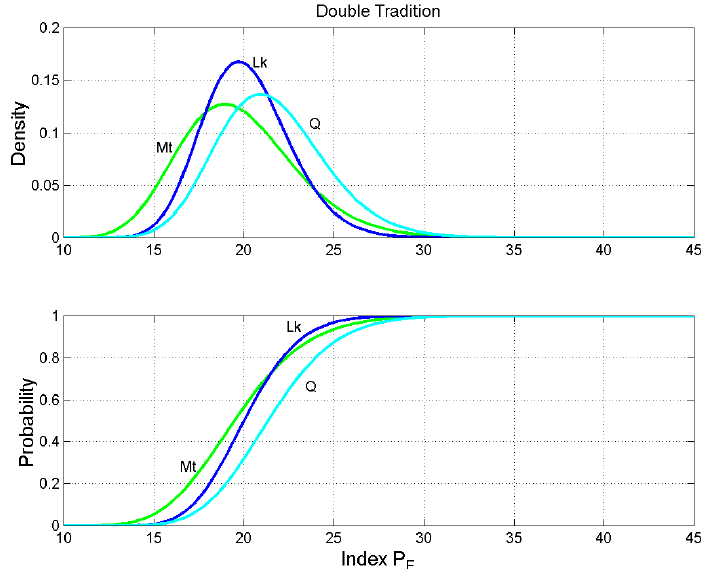
Figure 9. Double Tradition and Q. Probability density functions (upper panel) and probability distribution functions (lower panel) of the number of words per sentence 𝑃 𝐹 . Matthew : green line; distribution functions (lower panel) of the number of words per sentence P F . Matthew : green line; Luke : Luke : blue line; Q : cyan line. blue line; Q : cyan line. Table 12. Double Tradition. Kolmogorov–Smirnov test results for P F (below the diagonal of zeros) and C P (above the diagonal). The values reported are the confidence level (%) that the indicated couple of probability distributions are not